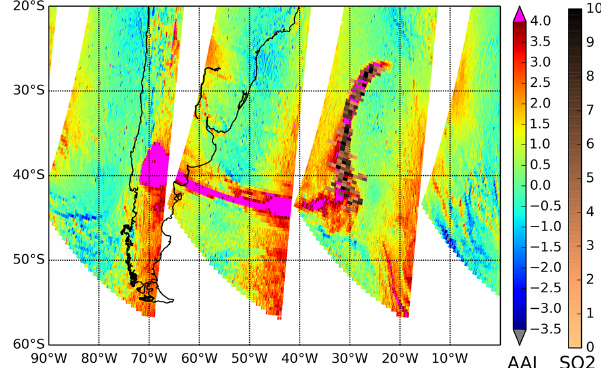
Figure 18. Absorbing aerosol index from the PMD bands from GOME-2A on 6 June 2011 over the south Atlantic Ocean. The plume of aerosol originates from an eruption of the Puyehue vol- cano. The GOME-2A SO 2 data are plotted over the AAI values to show how the AAI and SO 2 products see the dispersions of the volcanic ash and SO 2 clouds, respectively. The SO 2 values are in Dobson Units with a different colour